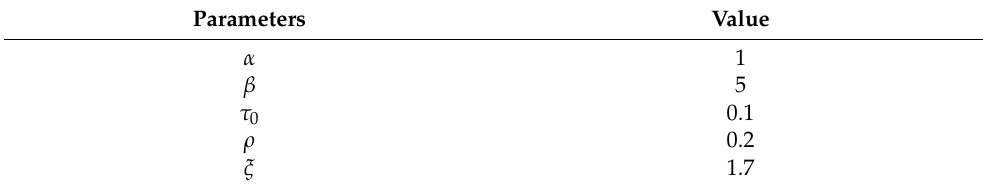
Table 1. Parameters of